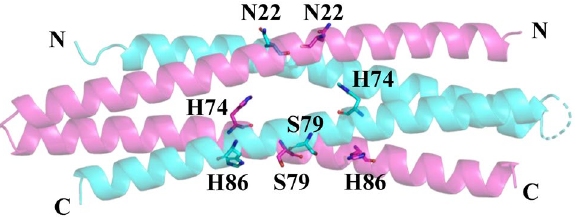
Figure 1. Target residues for mutations to stabilise the de novo protein WA20 in the present study. The target amino acid residues are shown as sticks. Chains A and B of the crystal structure of WA20 (PDB: 3VJF) 16 are shown in magenta and cyan, respectively. The images were created using open- source PyMOL, version 2.4 (https:// github. com/ schro dinger/ pymol- open-